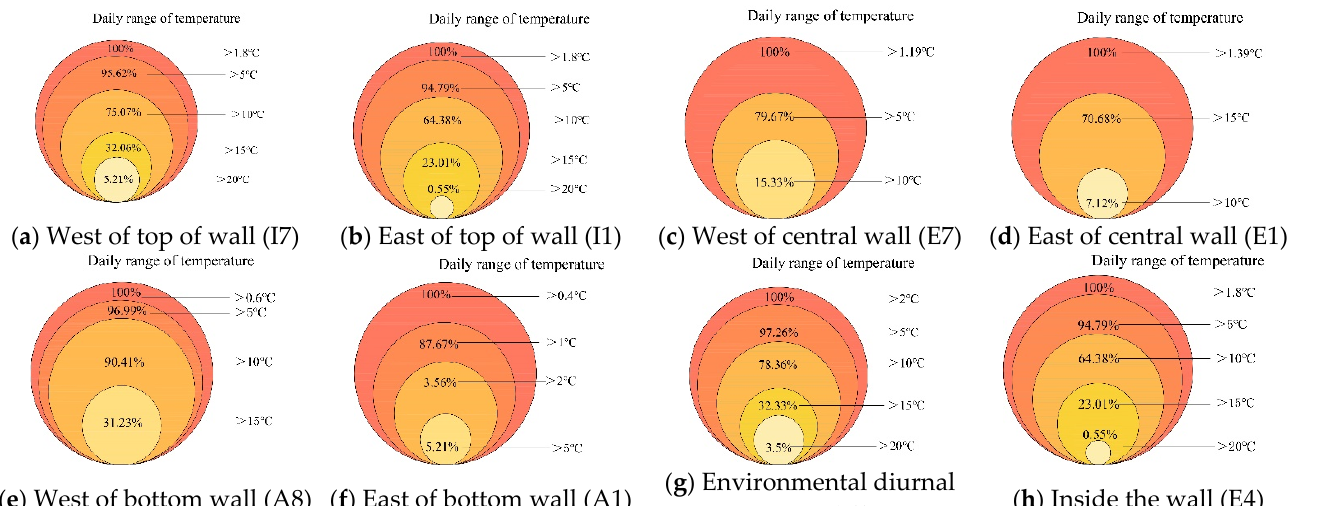
Figure 29. Temperature field of test wall across one year. 6. Conclusions Heat conduction, convection, and radiation were identified as the main factors that caused temperature changes in rammed earth walls. The wall surface temperature changed sharply, while the interior remained relatively stable and showed a decreasing gradient, which was the external force for the weathering at the surface of the wall. The temperature field was responsible for the changes to the solid, liquid, and gaseous phases of water, which was the main mode of energy storage and release. Particularly in spring and winter, the alternating temperatures above and below 0 °C were more obviously responsible for the deterioration of the wall surface. The main conclusions were as follows: (1) The order of the intensity of temperature changes at different positions on the wall, from high to low, was the top west, top east, top center, middle and upper part of the western wall surface, middle and upper part of the eastern wall surface, middle and lower part of the western wall surface; middle and lower part of the eastern wall surface, inner upper side, inner lower side, and finally internal middle. The daily temperature difference on the top surface of the wall was more than 10 °C, accounting for 75% of the days, and the temperature difference inside the wall did not exceed 2 °C. Temperature difference circulation was the main external cause of weathering on the wall surface. (2) The maximum temperature difference on the surface of the wall was 62.99 °C. The daily gradual change of temperature was not more than 0.6 °C, and the maximum daily temperature difference was 24.3 °C. The changes were the most prominent in